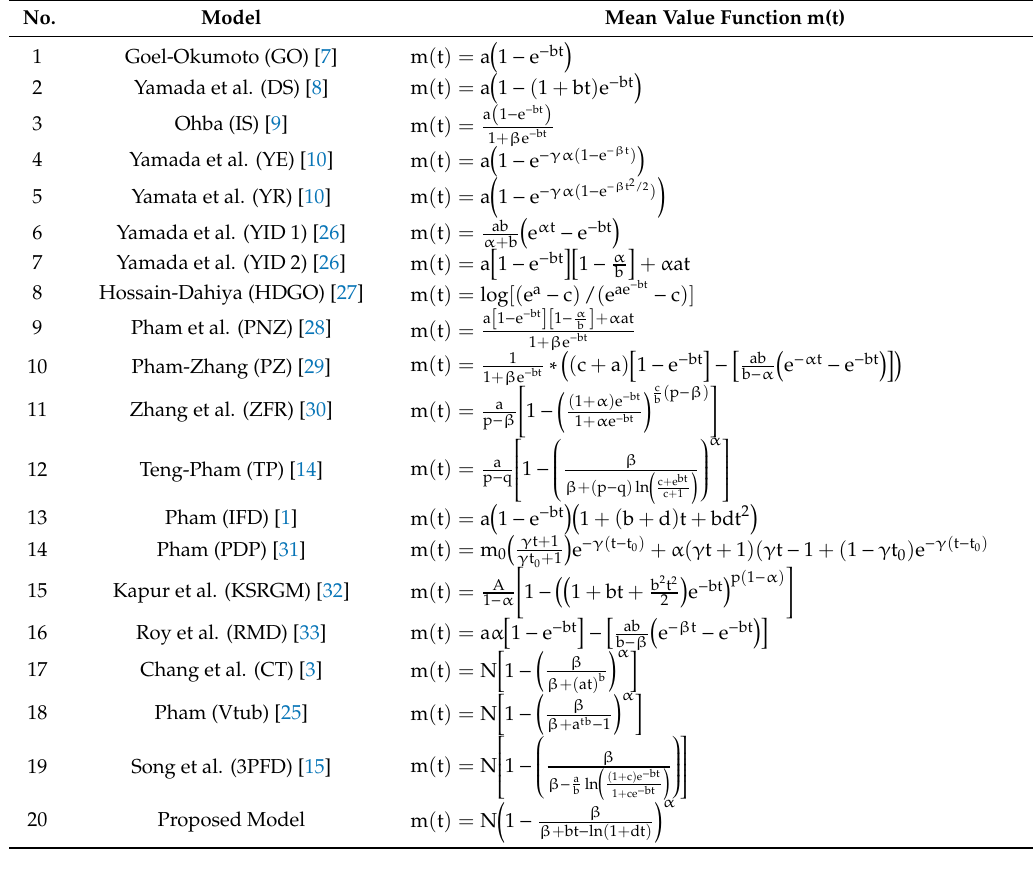
Table 1. NHPP software reliability